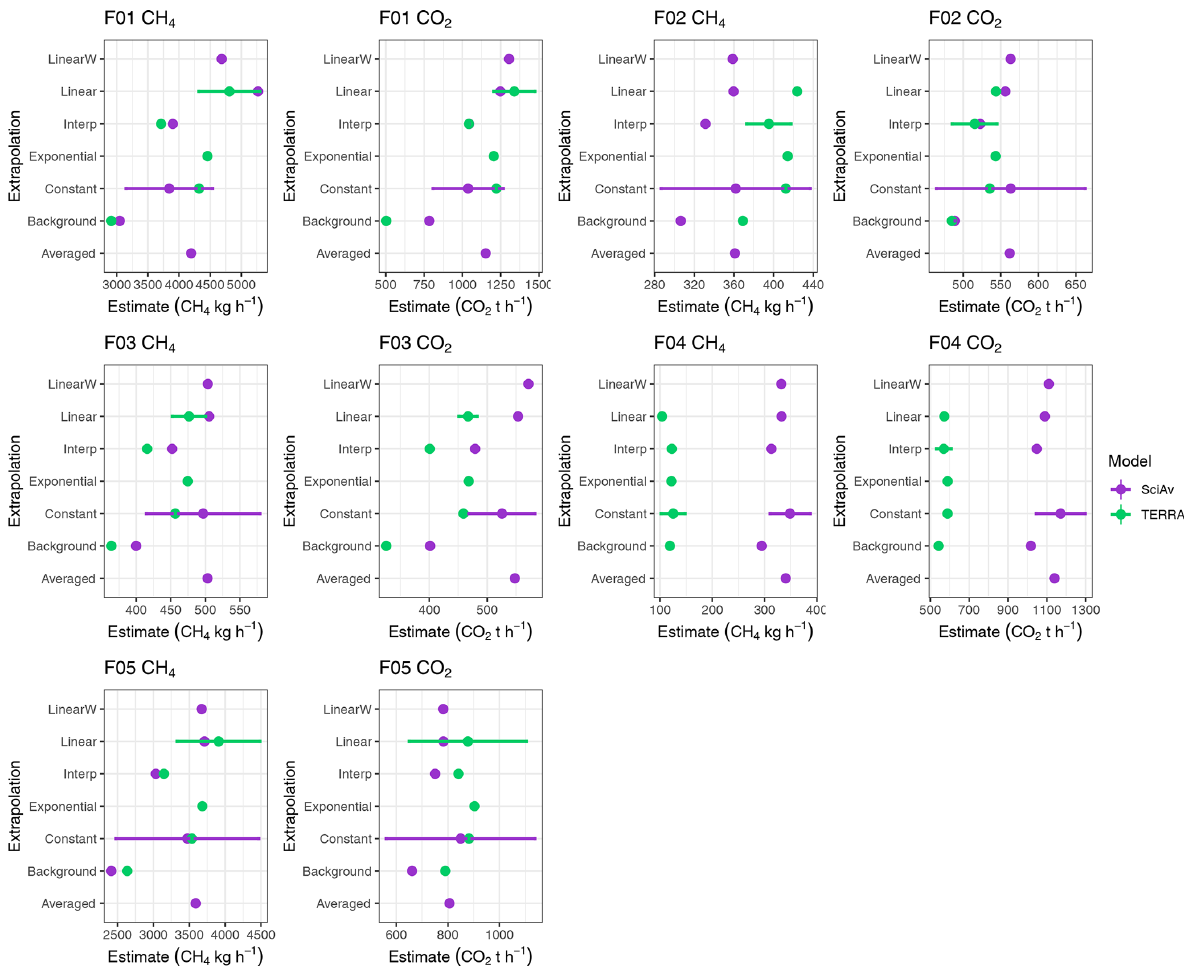
Figure 7. CH 4 and CO 2 estimates, based on various surface extrapolation fits, are plotted in purple for the SciAv estimate and green for TERRA. Error bars are drawn onto each algorithm’s standard